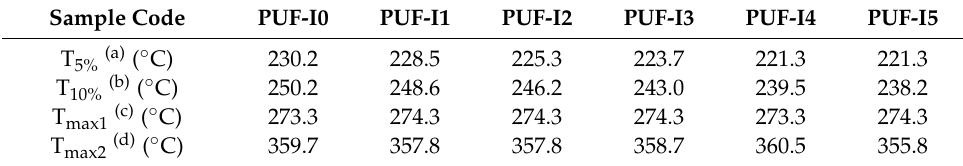
Table 4. Characteristic decomposition temperatures of various FPUF.